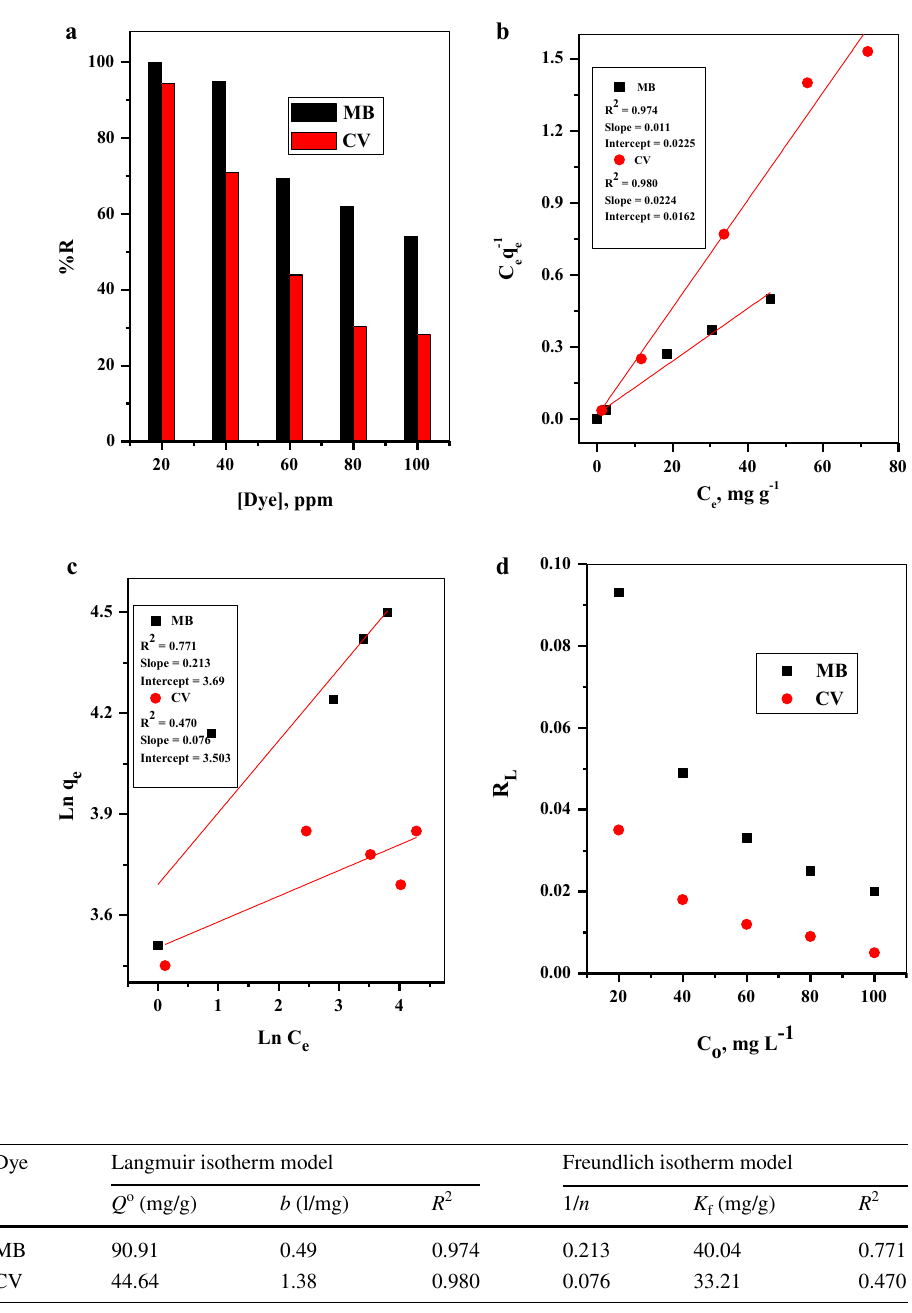
Fig. 5 a Effect of dye con- centration on removal percent of MB dye and CV dye, b Lang- muir isotherm plots for removal of MB and CV dyes, c separa- tion factor ( R L ) and d Freun- dlich isotherm plots for removal MB and CV dyes from pure water by m-AS. MB → m-AS dose = 0.03 g, time = 10 min., T = 25 °C, pH = 7, t = 10 min, V = 50 ml; CV → m-AS